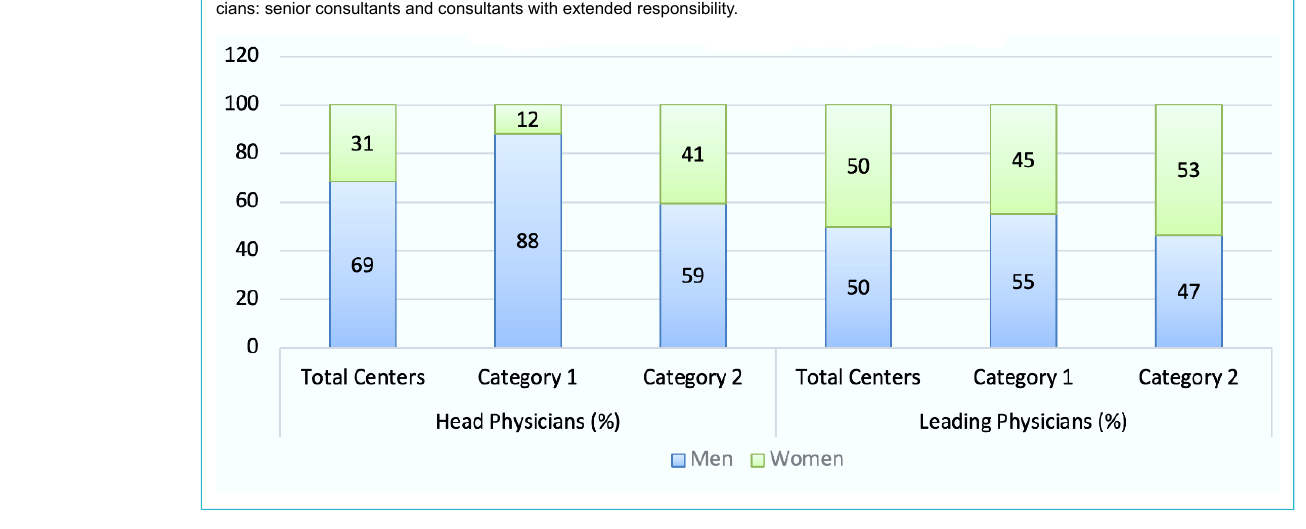
Figure 1: Gender distribution among head and senior physicians of Swiss SSERM-certified emergency departments in 2021. Leading physi- cians: senior consultants and consultants with extended